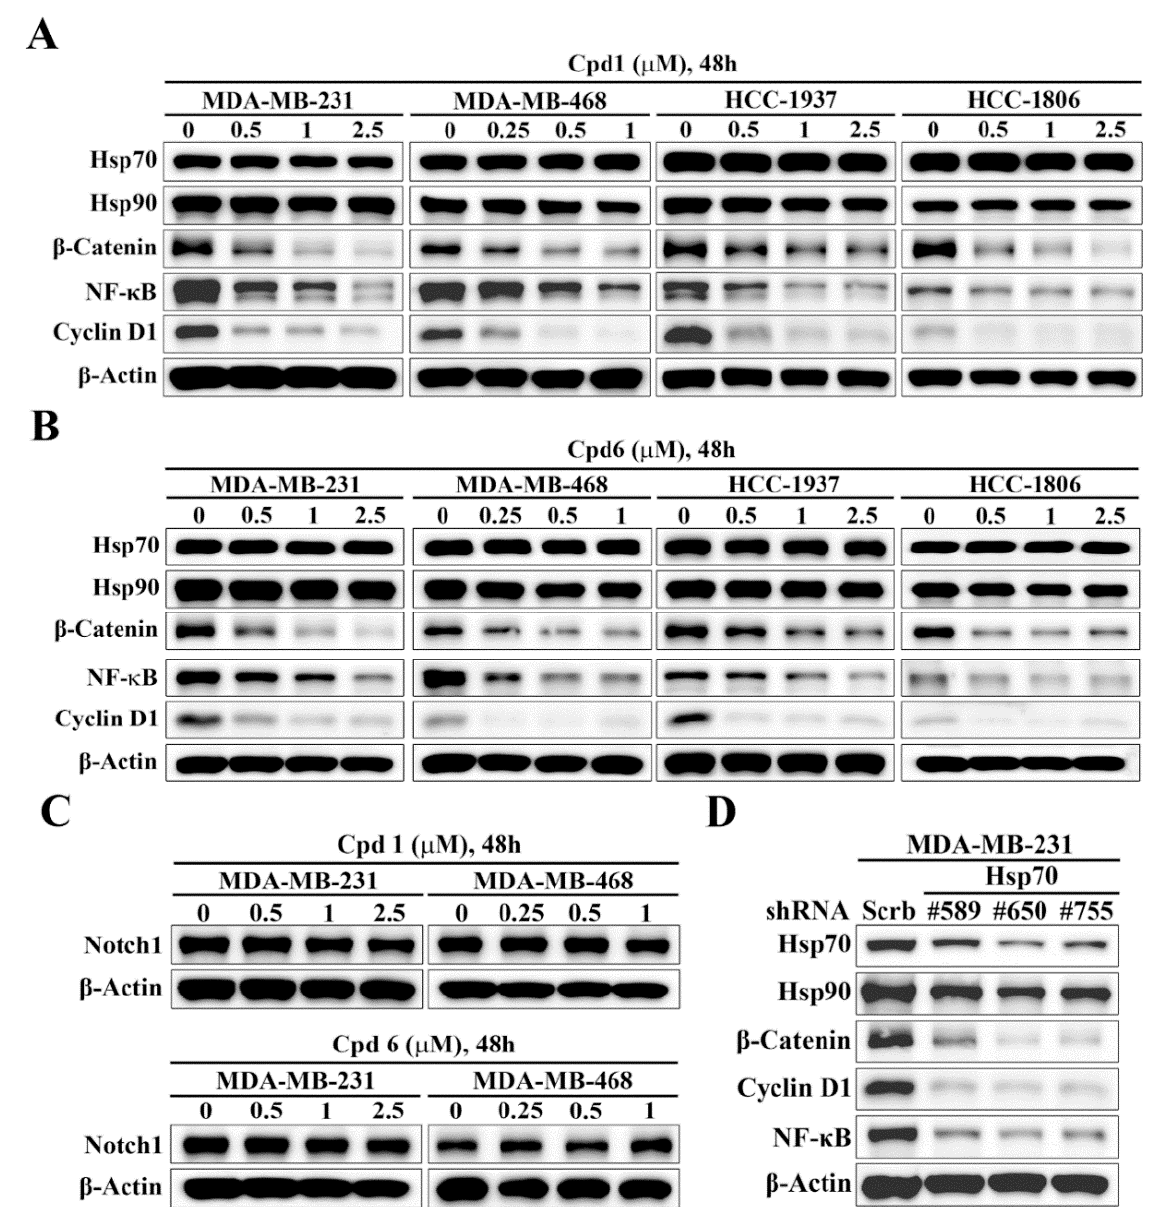
Figure 5. Evidence that Hsp70 regulates the expression of β -catenin and its downstream target genes. Western blot analyses of the effect of ( A ) compound 1 and ( B ) compound 6 on the expressions of Hsp70, Hsp90, β -catenin, Cyclin D1, and NF- κ B in MDA-MB-231, MDA-MB-468, HCC-1937, and HCC-1806 cells. ( C ) Western blot analyses of the effect of compound 1 (upper) and compound 6 (lower) on the expression of Notch1 in MDA-MB-231 and MDA-MB-468 cells. ( D ) Western blot analysis of the effect of stable knockdown of Hsp70 on the expressions of Hsp70, Hsp90, β -catenin, Cyclin D1, and NF- κ B in MDA-MB-231 cells.